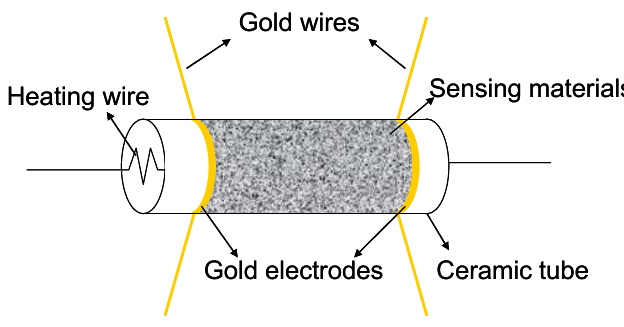
Figure 3. Device structure based on ceramic tube